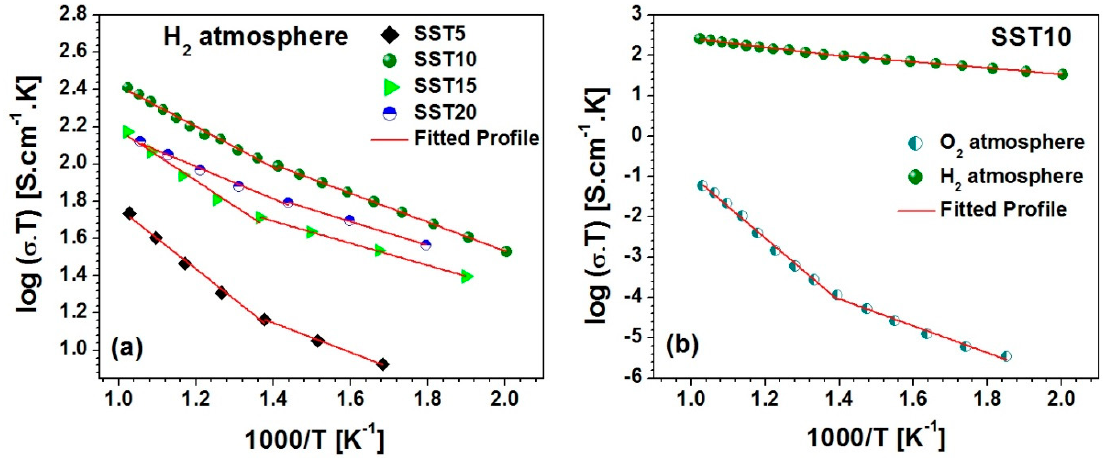
Figure 8. ( a ) The Arrhenius plot (log ( σ dc T) vs. 1000 / T) for the all studied samples and ( b ) the comparative Arrhenius plot for the sample SST10 in O 2 and H 2 atmospheres.